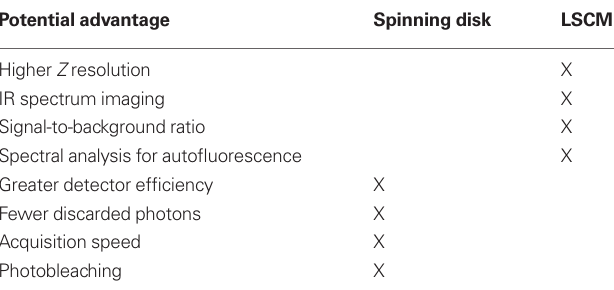
Table 1 | Comparison of spinning disk confocal microscope and LSCM for human postmortem tissue